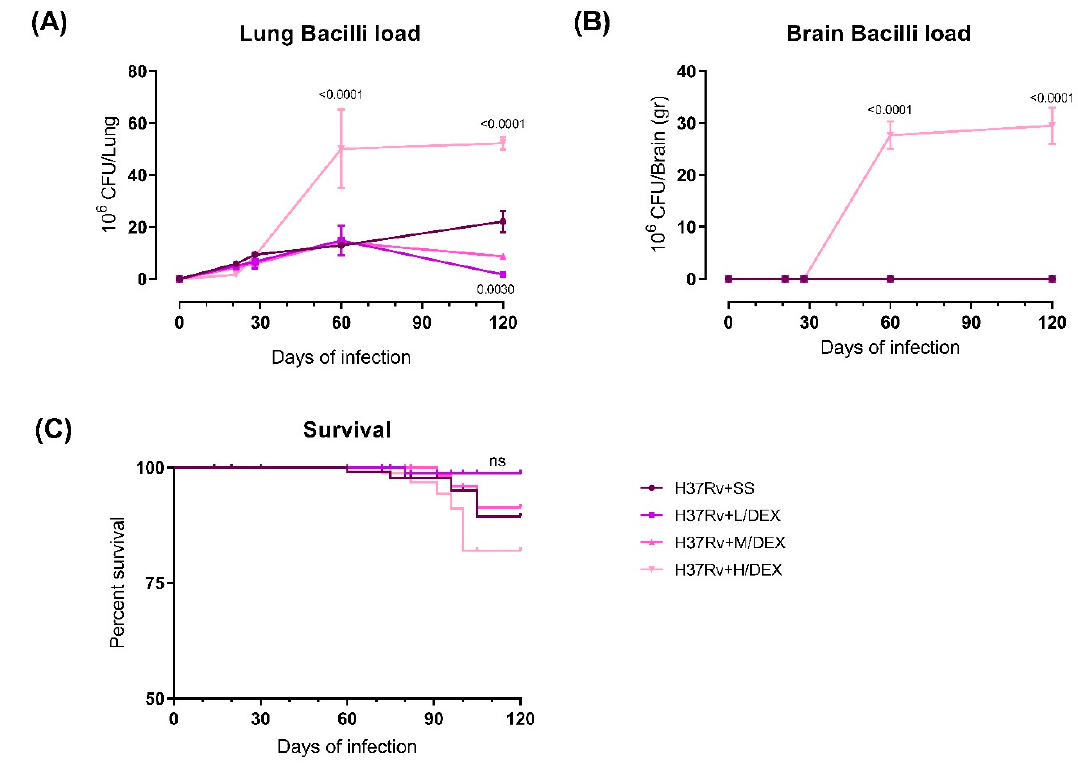
Figure 1. Effect of IN L/DEX (0.05 mg/kg BW), M/DEX (0.25 mg/kg BW) and H/DEX (2.5 mg/kg BW) starting in the early TB infection (14 days post-infection) on lung disease evolution of infected mice with 2.5 × 10 5 colony-forming units (CFU) of M. tb . ( A ) Bacillary loads at lungs homogenates of control mice that only received the vehicle saline solution and infected animals treated with IN DEX F (3, 8) = 16.8, p = 0.0008, Two-way analysis of variance (ANOVA). Tukey’s multiple com- parisons test. ( B ) Bacillary loads determined at brain homogenates from control mice and animals treated with saline solution and treated with IN DEX since day 14. F (3, 8) = 104.8, p < 0.0001, Two-way ANOVA. Tukey’s multiple compari- sons test ( n = 6). ( C ) Survival rates of control mice treated with saline solution and treated with IN DEX ( n = 36). p = 0.2191, Logrank test for trend. Data are presented as mean +/ − SEM. The H/DEX dose significantly increased the bacterial load in the lung and brain from day 60 post-infection and decrease survival rate, while the L/DEX and M/DEX doses did not increase the number of bacteria in these organs. Thus, L/DEX and M/DEX doses are safe to administer in animals infected with Mtb , as they do not aggravate lung disease. 2.2. The Effect of Intranasal Low Dose DEX Treatment Since Early TB Infection on Diverse Behavioural Abnormalities In previous work we observed that pulmonary infection with M. tb induced sickness behavior, manifested by a significant decrease in body weight and locomotor activity in infected animals [33]. Sickness behavior is a response related to the inflammatory process. Thus, we determined the effect of IN L/DEX and M/DEX doses administration during early Mtb infection on sickness behavior. The results showed that the treatment with L/DEX and M/DEX doses decrease the sickness behavior of TB mice (Figure 2). There was a slight improvement in body weight, mostly at 90- and 120-days post-infection and loco- motor activity (LMA) was also significantly improved after one week of treatment.